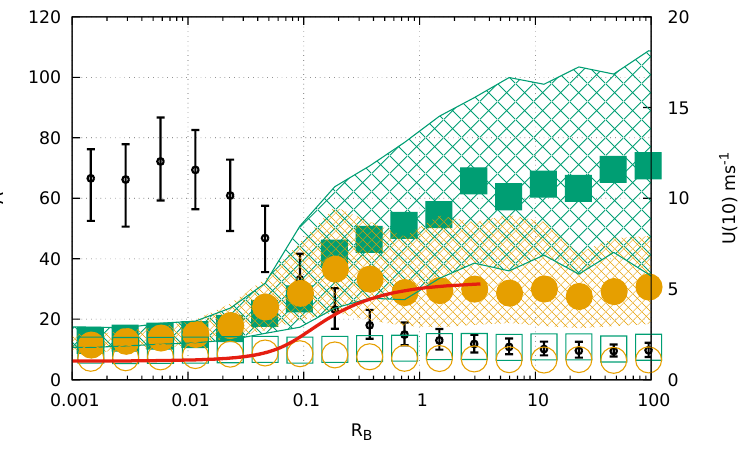
Figure 3. A as a function of R B . Squares and the shaded green area are the median and the range 25–75% percentiles for observations at z = 2 m; dots and brown area the same for z = 9 m; both averaged over 30 min. The open symbols correspond to the medians for data averaged over 2 min. Small black circles with error bars indicate the wind velocity measured at z = 10 m on the neighboring mast. The red line corresponds to the theoretical behavior from